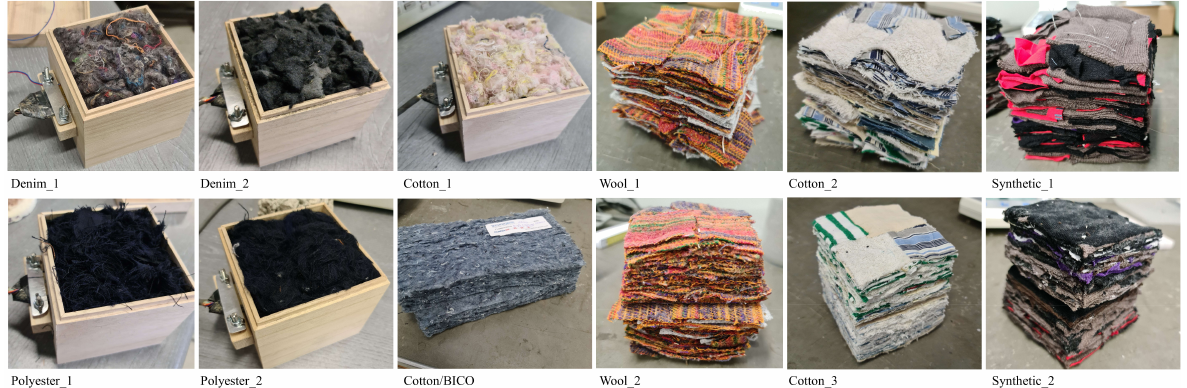
Figure 2. Tested textile samples. Dimensions: 10 cm 3